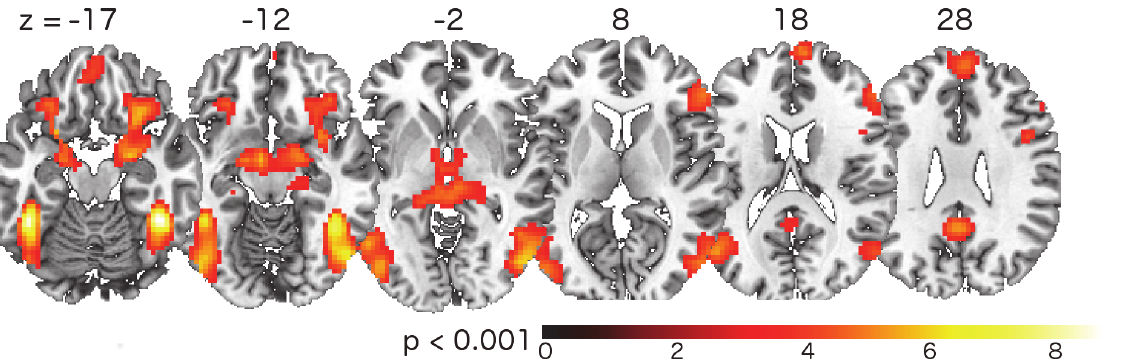
Fig 6. Main effect of emotion. All subjects ’ t-map results for the second level analysis of ‘ negative > neutral ’ contrast.